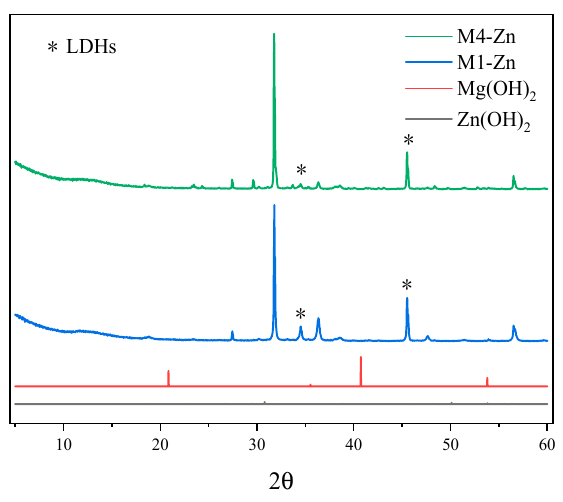
Figure 8. X-ray diffraction results for some Zn-doped MMH samples.